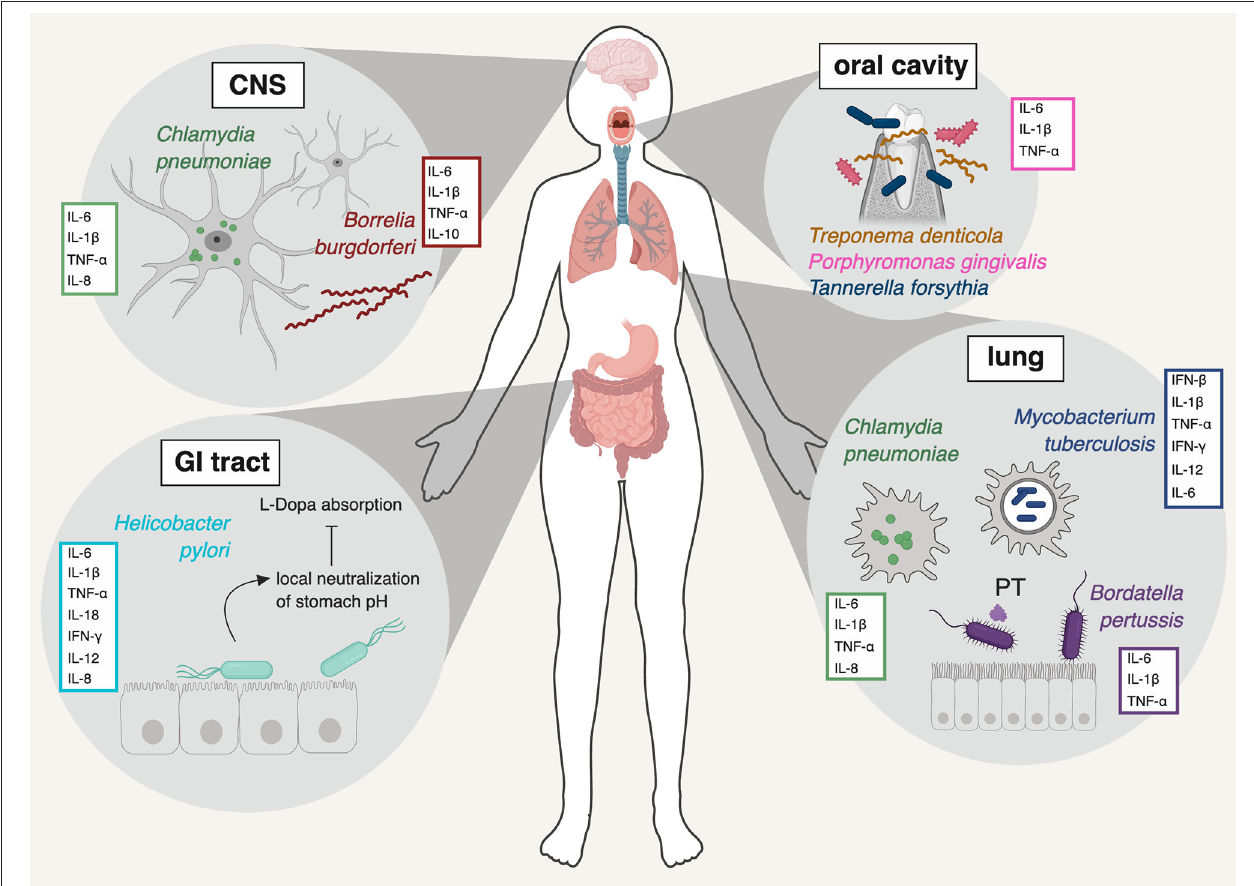
FIGURE 1 | Schematic representation of the pathogens discussed in this review, the major organ system(s) they infect, and the primary innate immune cytokines they induce. Chlamydia pneumoniae is shown in its primary location (lung) but also in the CNS, where the bacterium has been repeatedly detected in association with